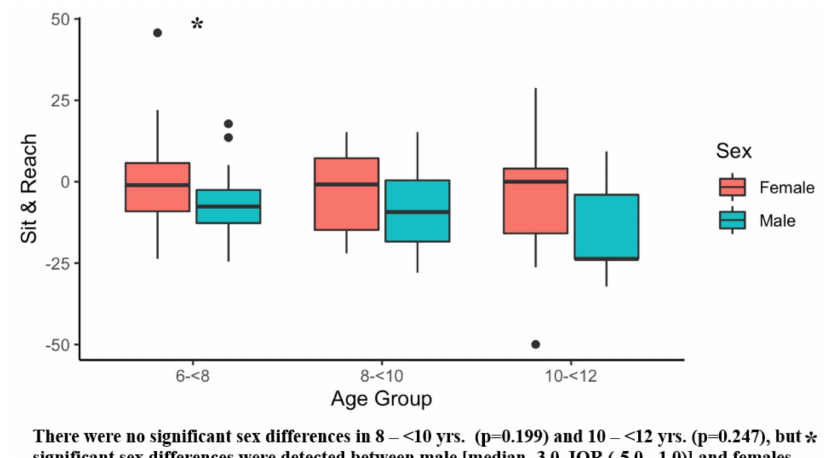
Figure 3. Vertical Jump. Black dots are outliers.